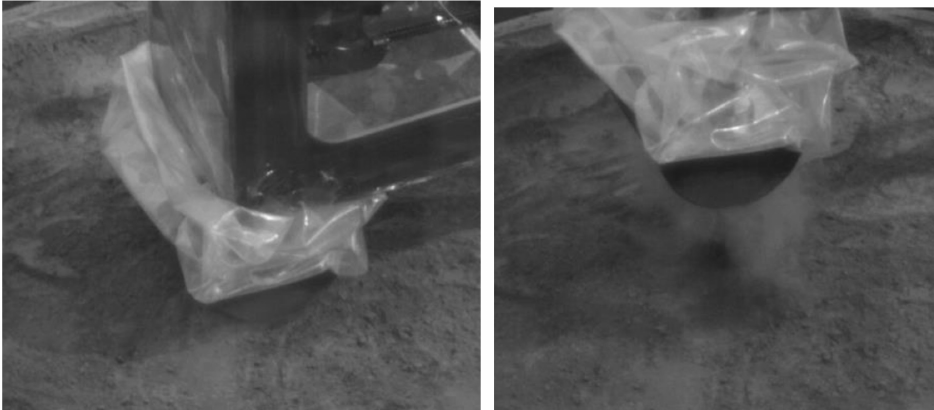
Figure 18. Jump in Syar with the foot in configuration #1.